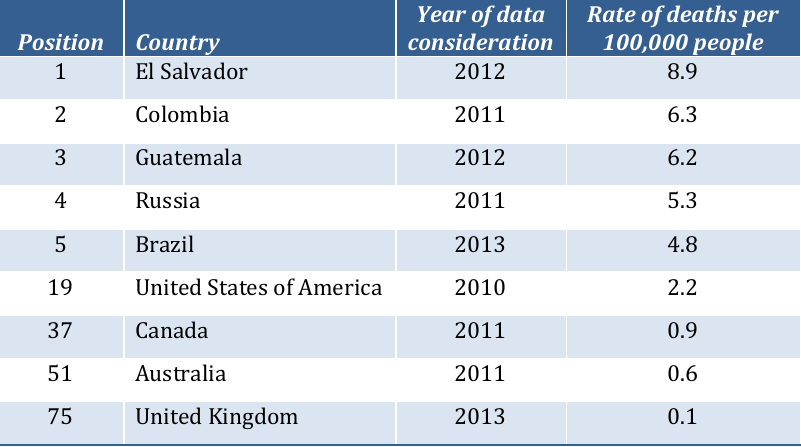
Table 1: International ranking of female